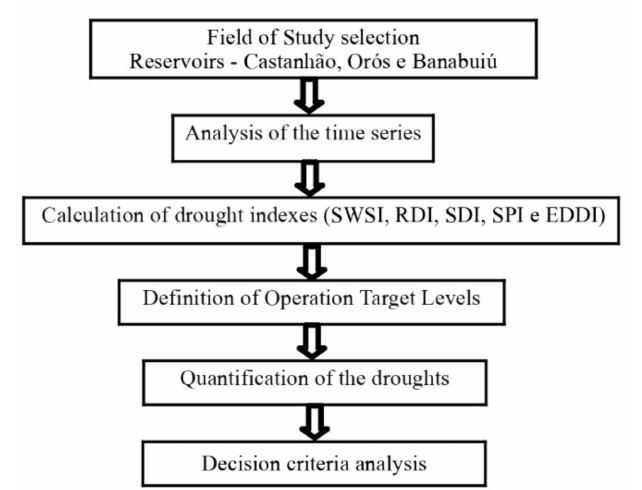
Figure 1. Diagram of the methodology